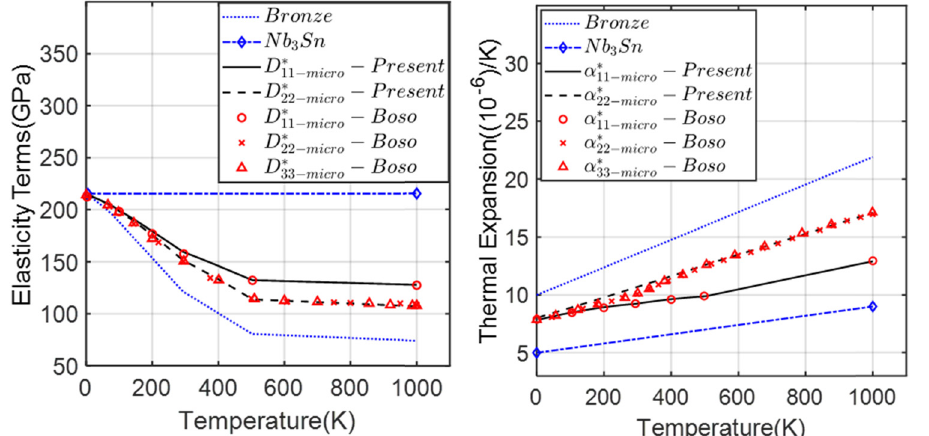
Figure 8: Comparison of homogenized main diagonal elasticity terms ( Left ) and thermal expansion coe ffi cients ( Right ) generated by LEHT and Boso et al. [ 13 ] with v 0.42 f = for Nb 3 Sn fi laments at